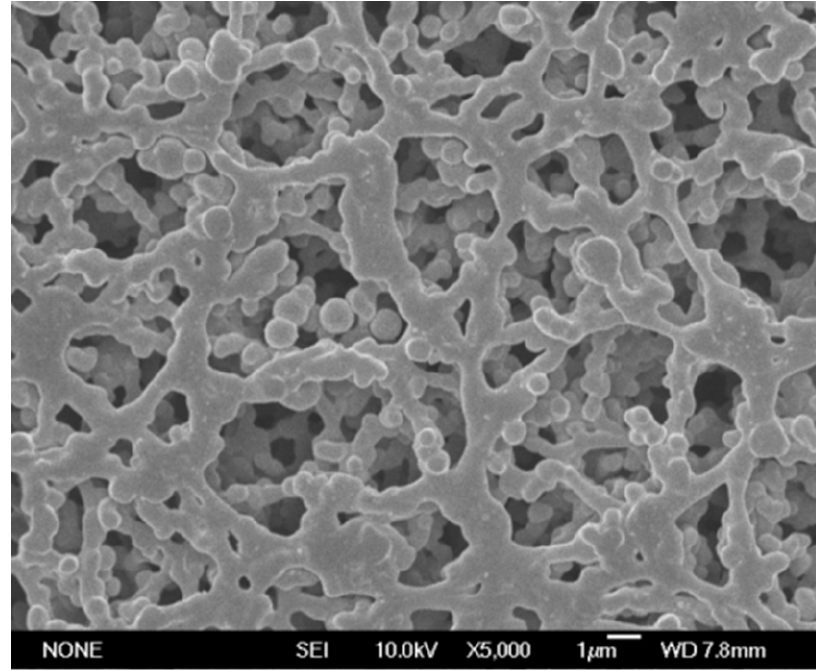
Figure 2. SEM photo of cellulose membrane.